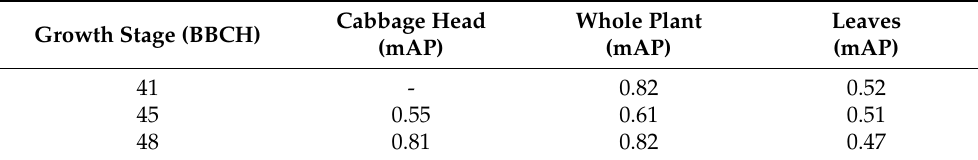
Table 1. Mean average precision (mAP) of cabbage head, whole plant, and leaves, at different growth stages